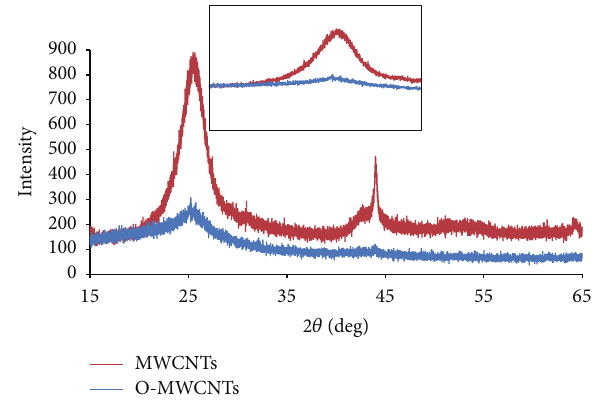
Figure 5: XRD for MWCNTs and O-MWCNTs.